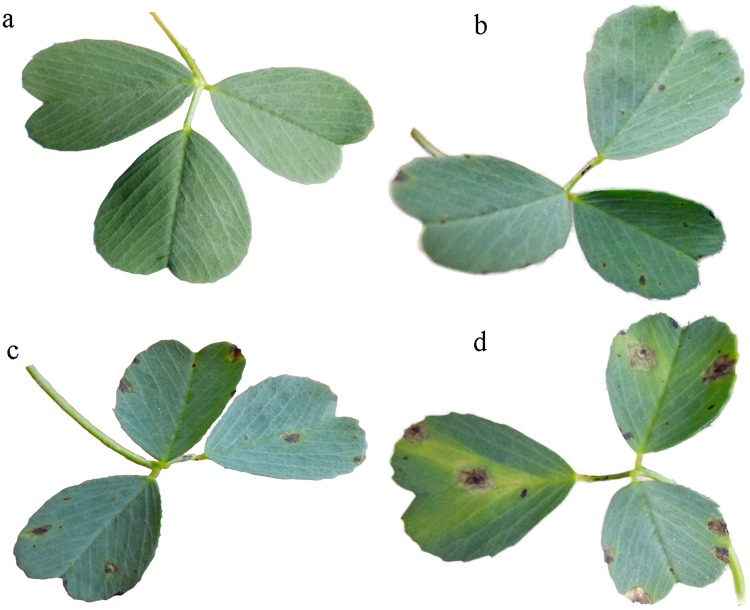
Symptoms on alfalfa inoculated with Phoma medicaginis var. medicaginis.The symptoms observed at 8 d (b), 19 d (c) and 26 d (d) after inoculation, and without inoculation (controls) (a).